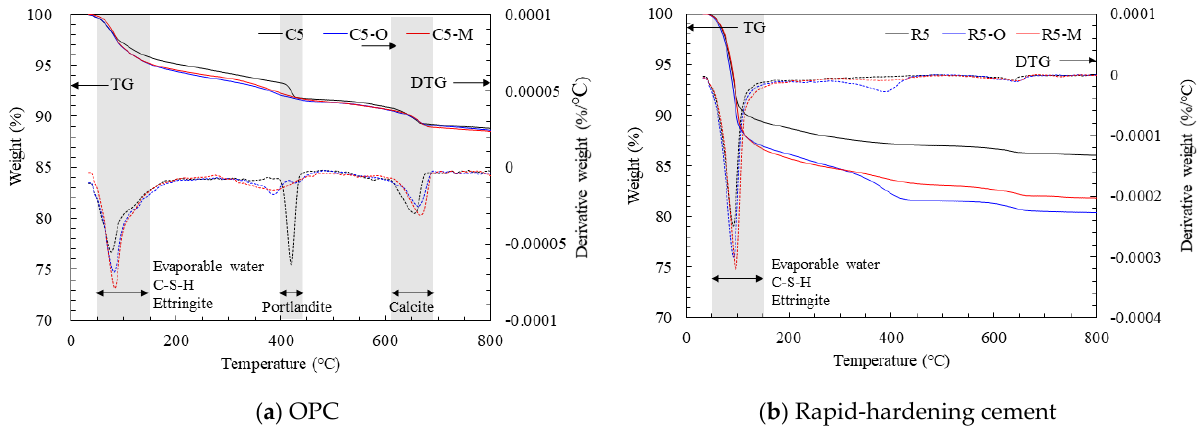
Figure 4. TG-DTG of the cement mortar mixtures with water repellents at 28 days of age.